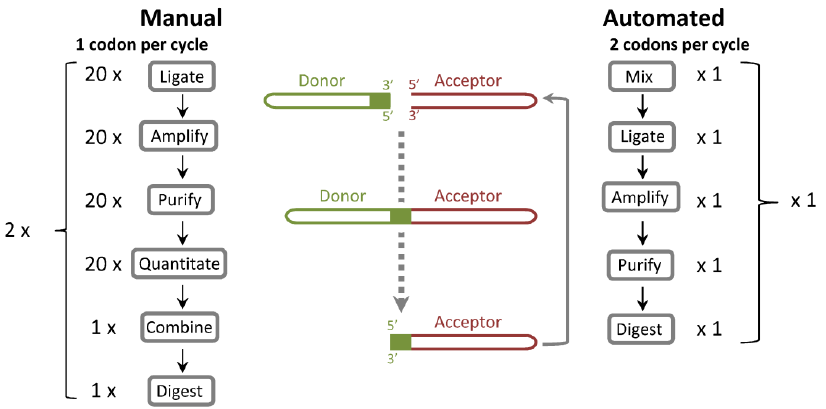
Figure 1. Comparison of ProxiMAX and automated, hexamer-based ProxiMAX (Colibra™) processes. In the manual process, codons are ligated separately, amplified, purified,